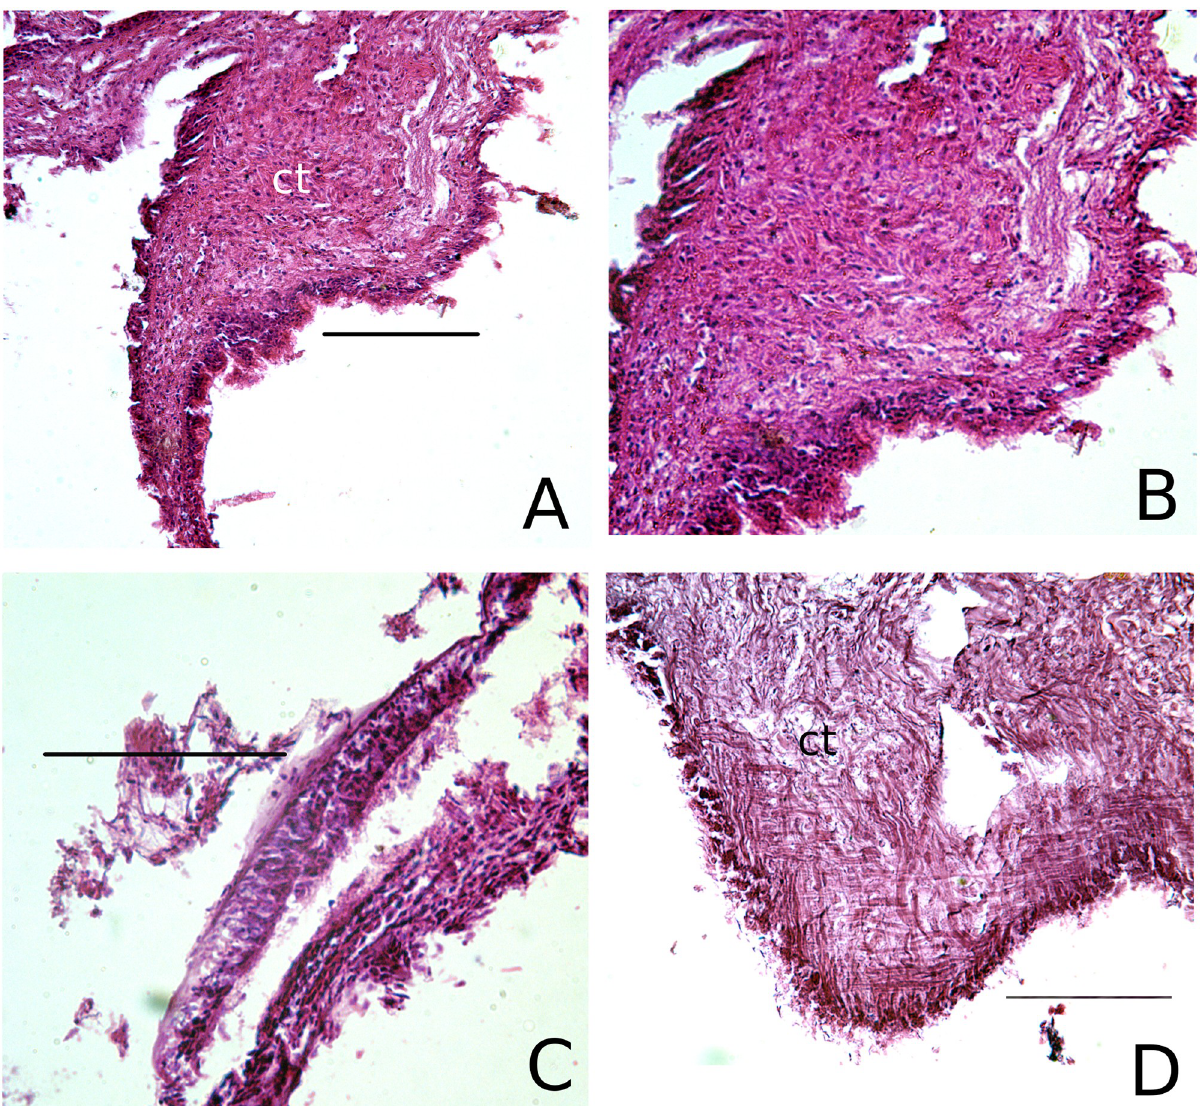
Fig 3. Metaplasially altered ctenidia of three individuals (A, B—Apalachicola; C—Apalachicola; D—Barataria Bay) from the Gulf of Mexico. A, B (a magnification of A) and D exhibit hyperplasia of the connective tissue and reduced epithelial structure. C exhibits stratified epithelium and a reduction of cilia on an otherwise developed ctenidial branch. Labels: ct—connective tissue. Scale bars in all images are 100 μ